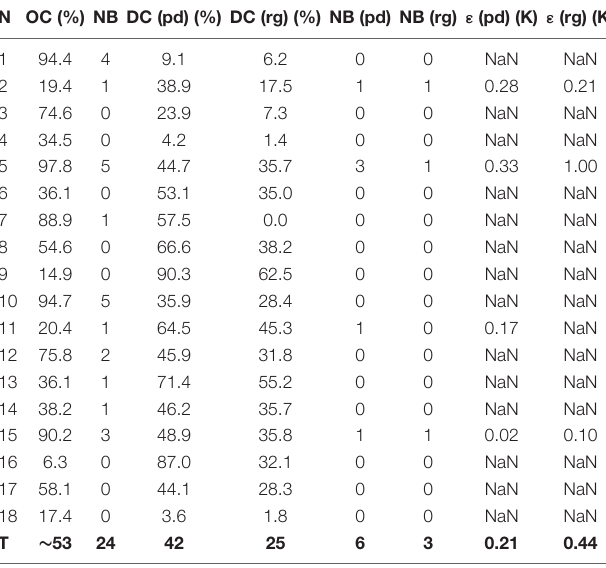
TABLE 3 | Statistical information of retrieved results for 19 granules from CB using two different methods of PDSST and RGSST5 for the month of September 2019.